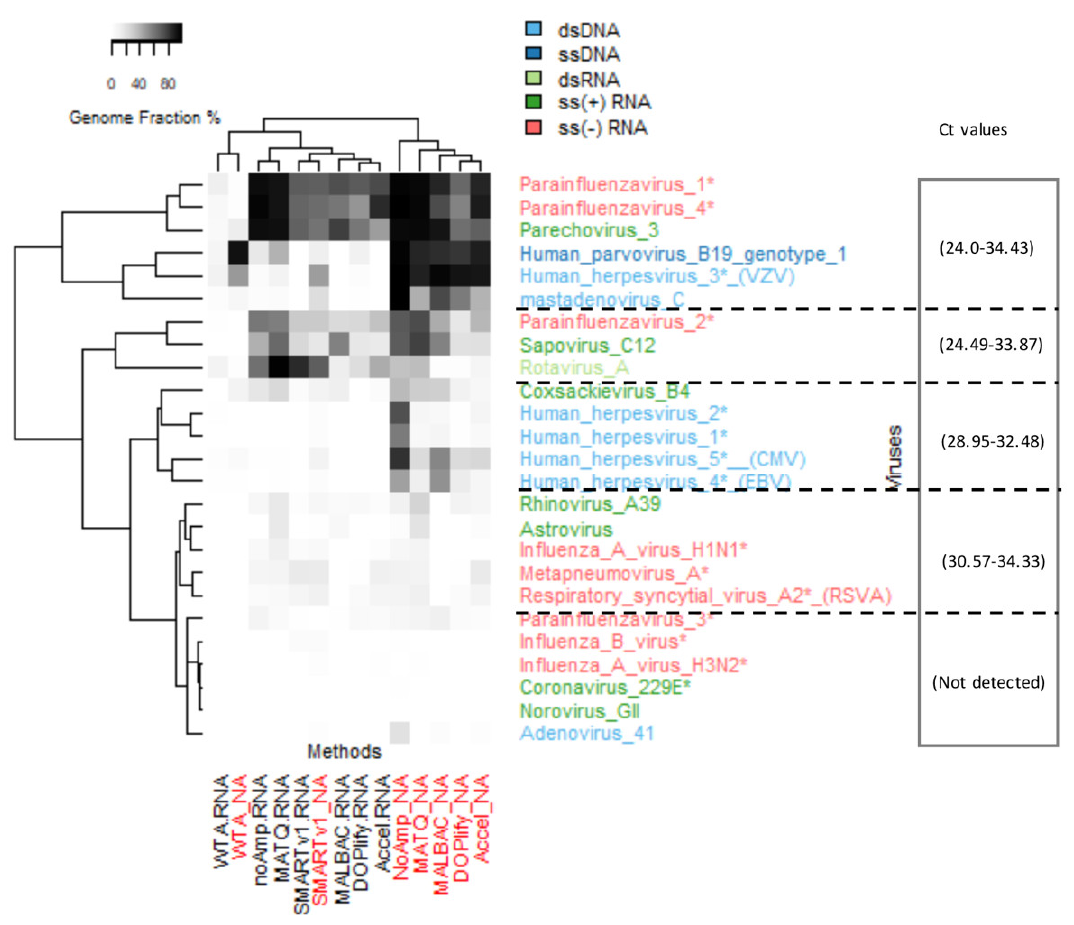
Figure 4. Heatmap of whole genome coverage of viruses of VMRP from seven methods in NA and RNA fractions. The genome fraction for each virus is in row and methods for both NA and RNA fractions are in column. Viruses are color- coded according to their genomic group (dsDNA, ssDNA, dsRNA, ss(+) RNA and ss(-) RNA). An asterisk * indicates the non-enveloped viruses. Norovirus GI detected by no method was removed. Ranges of Ct value previously determined [31] were reported per viral cluster.